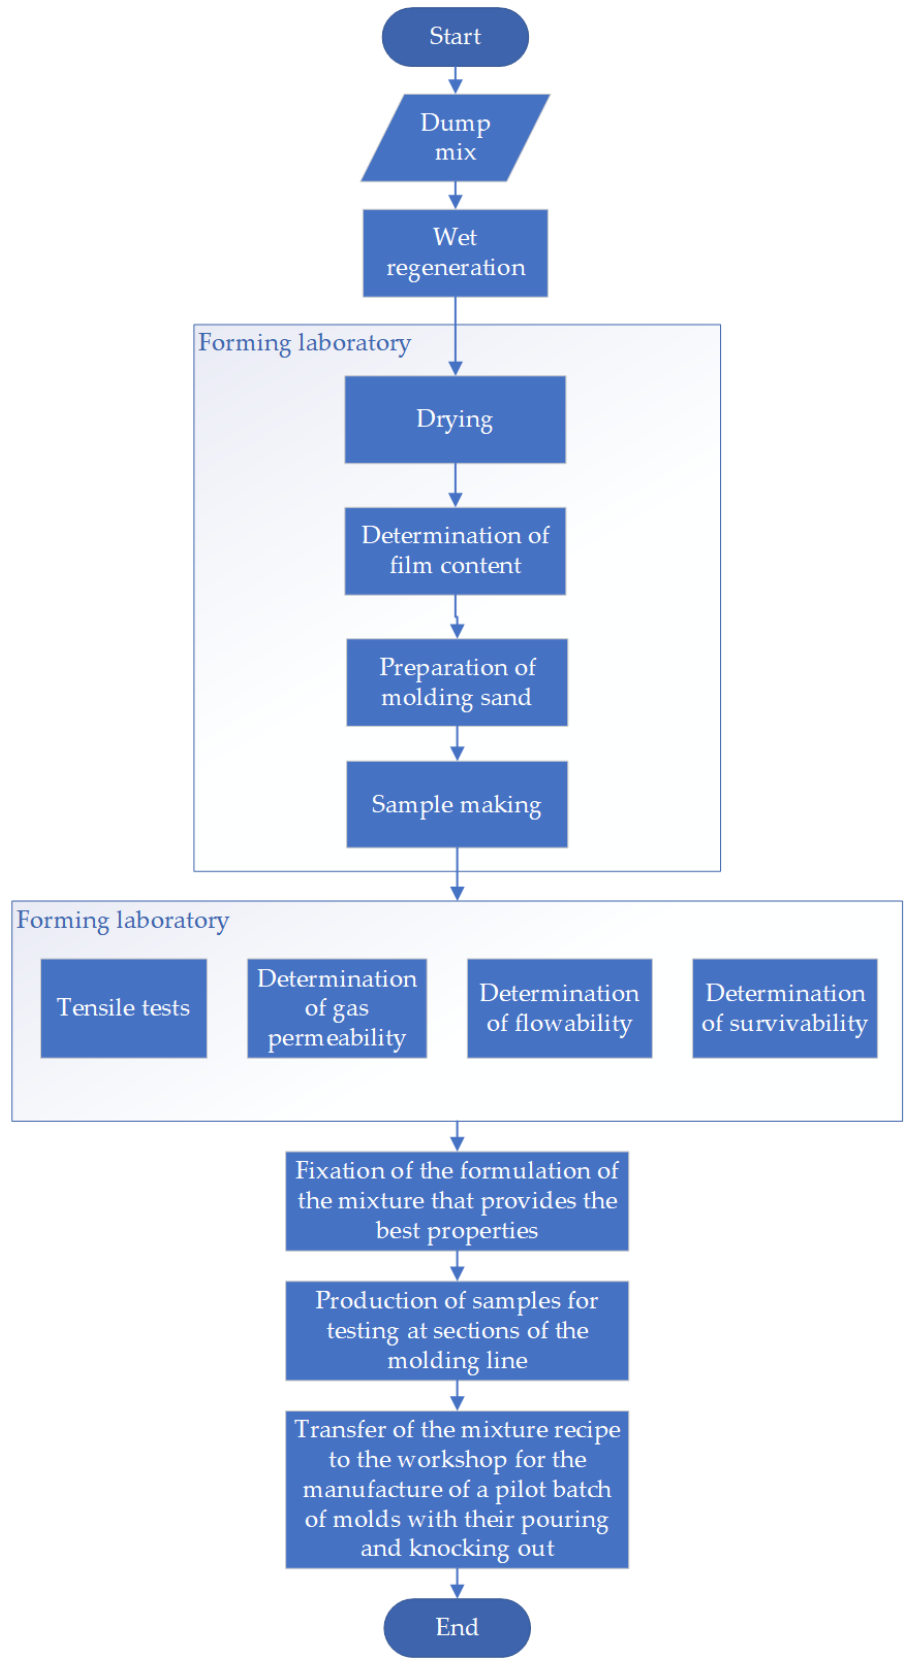
Figure 3. Research algorithm.